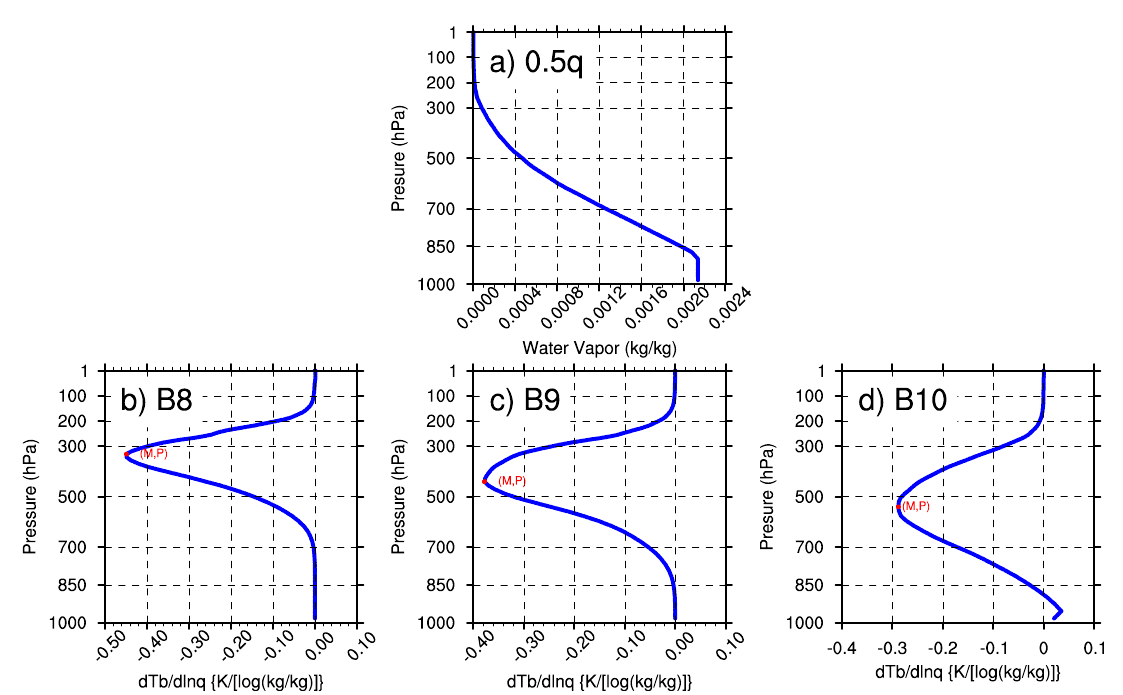
Figure 4. ( a ) Half of the water vapor content in Figure 3a. ( b )–( d ) Corresponding Jacobian functions (M) and the height of BWIL (P) of Band 8, Band 9 and Band 10, respectively.